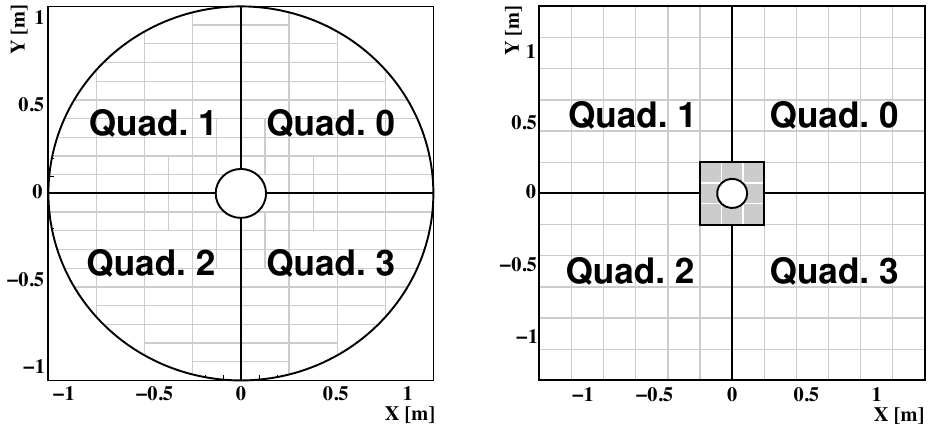
Figure 2. Layout of the tiles and quadrants of the CHOD detector (left), and the tiles, quadrants, and inner/outer regions of the MUV3 detector (right). The smaller, inner MUV3 tiles are shown in grey; quadrants only involve the large outer tiles shown in white. The hole in the centre of each detector allows the passage of the undecayed beam particles.